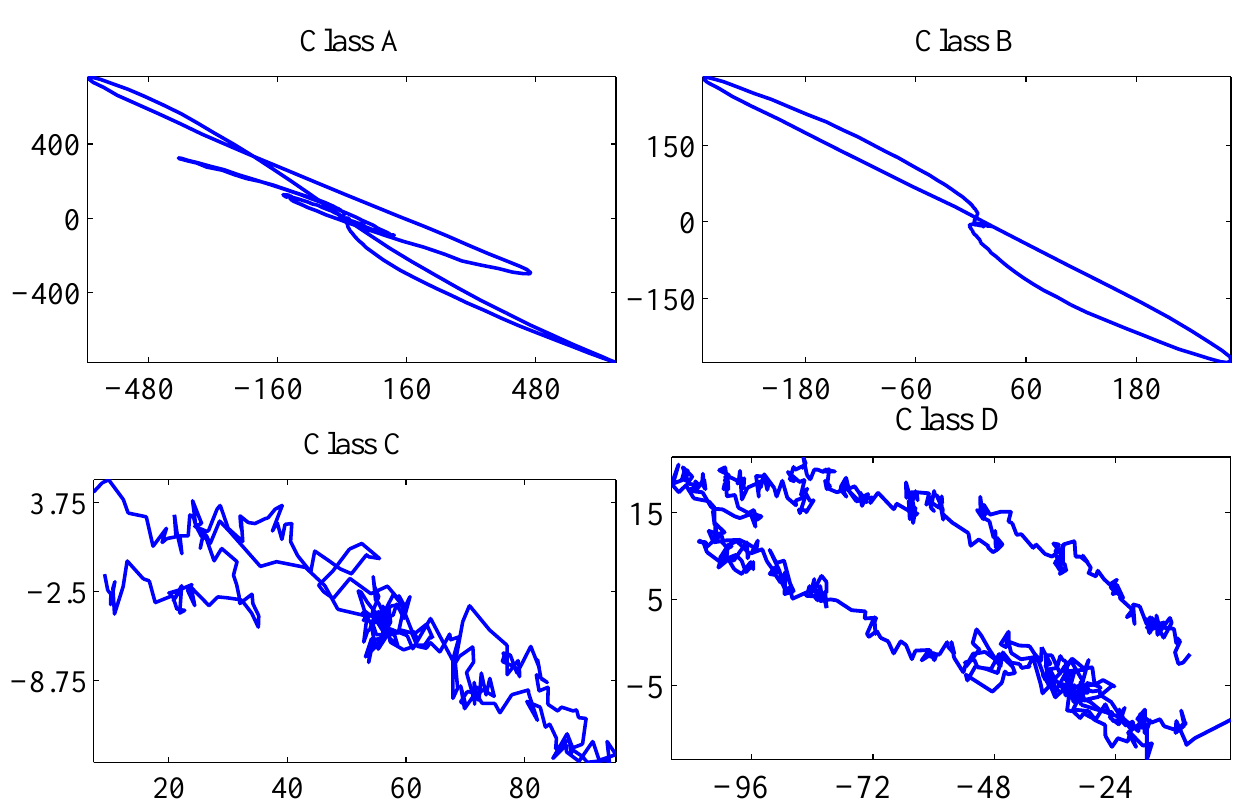
Figure 2. Individual defects belonging to each class represented in the complex impedance plane.